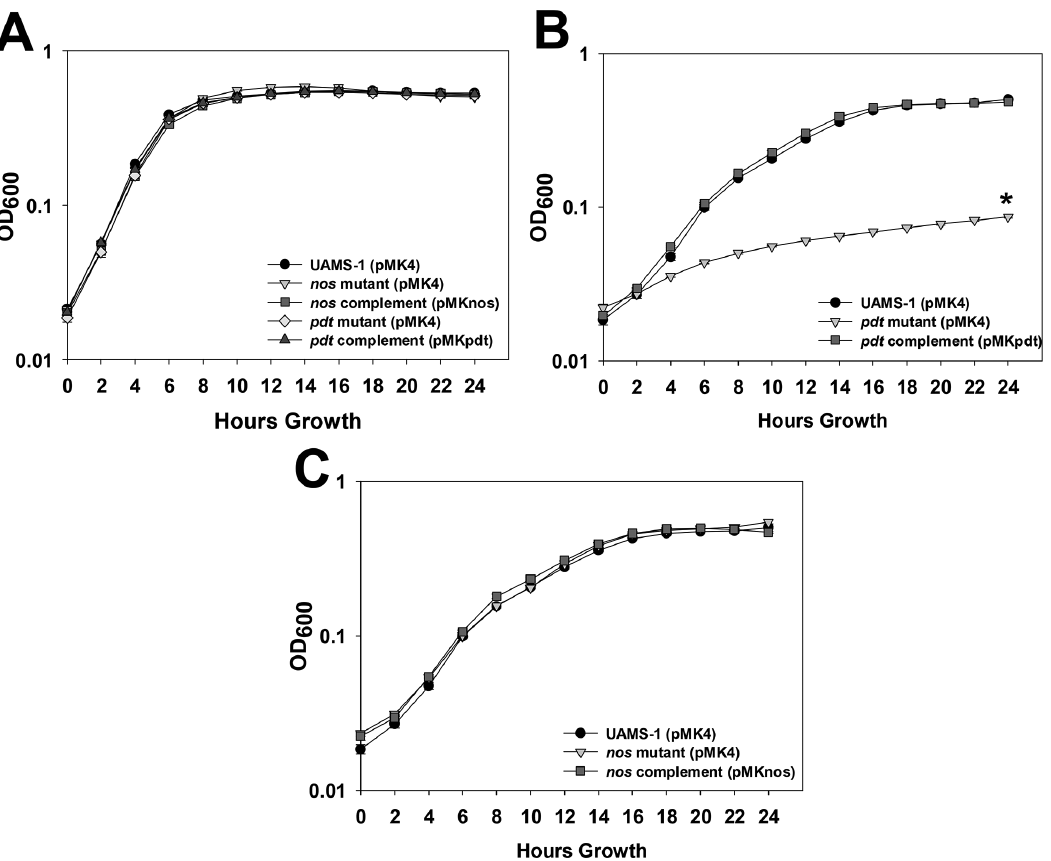
Figure 4. Effects of nos and pdt on growth in chemically-defined media. UAMS-1 (pMK4; wild-type), KR1010 (pMK4; nos mutant), KR1010 (pMKnos; nos complement), KR1013 (pMK4; pdt mutant), and KR1013 (pMKpdt; pdt complement) were grown in chemically-defined media in the presence (A) or absence (B and C) of phenylalanine. Cultures were inoculated to an OD 600 =0.02, and grown statically in a 96-well plate for 24 hours at 37 u C. OD 600 readings were measured every 2 hours using a microplate reader. Data represents the average of n=4 biological replicates acquired in 2 independent experiments. Error bars = SEM. *statistical significance of pdt mutant (pMK4) OD 600 compared to UAMS-1 (pMK4) at t=24 hours growth (p , 0.05, Tukey Test).